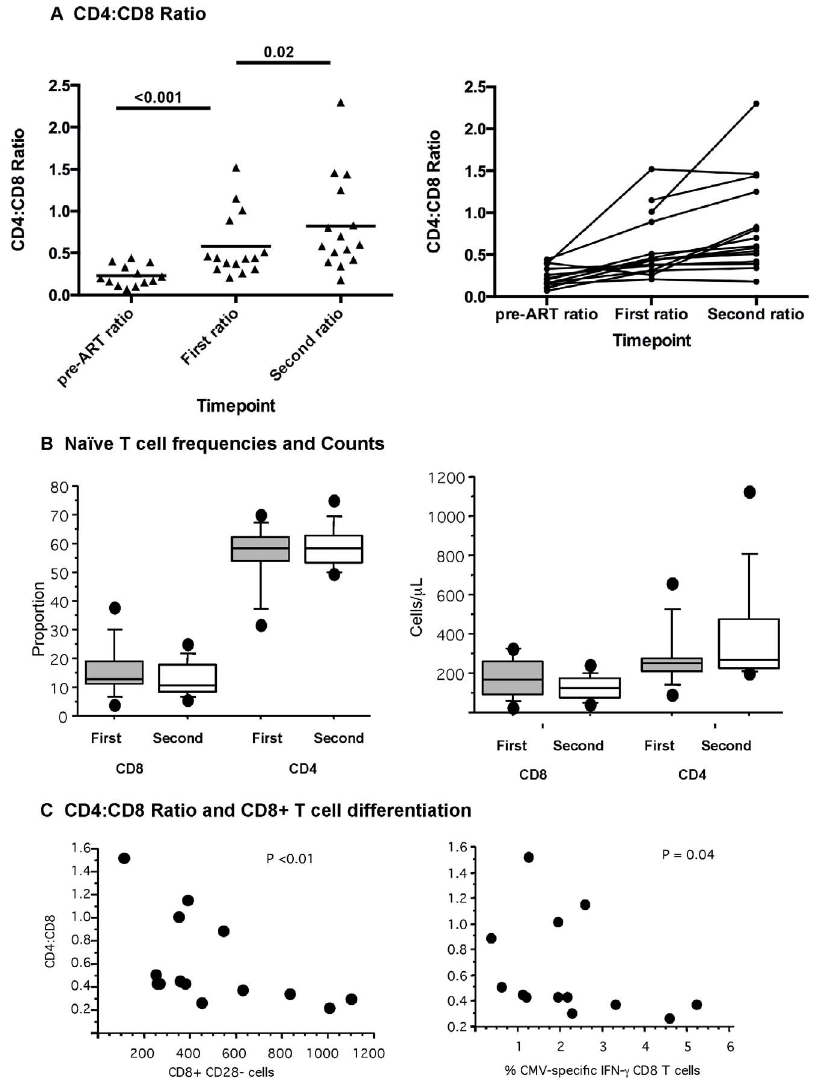
Figure 5. Longitudinal assessment of ART-suppressed subjects. (A) CD4:CD8 ratio in ART-suppressed Individuals at three timepoints (pre- ART, first timepoint on ART and second timepoint on ART). Subjects remained on antiretroviral therapy with suppressed viral load between ‘‘first’’ and ‘‘second’’ timepoint on ART. (B) Naı¨ve subpopulations defined as CD27 + CD28hiCCR7 + CD45RA + . Proportion and absolute number/ml are depicted for the first and second timepoint. (C) CD4:CD8 ratio in those suppressed on ART is shown in relationship to proportion of CD8 + CD28 2 cells and also in relationship to the proportion of CMV-specific CD8 + T cells.